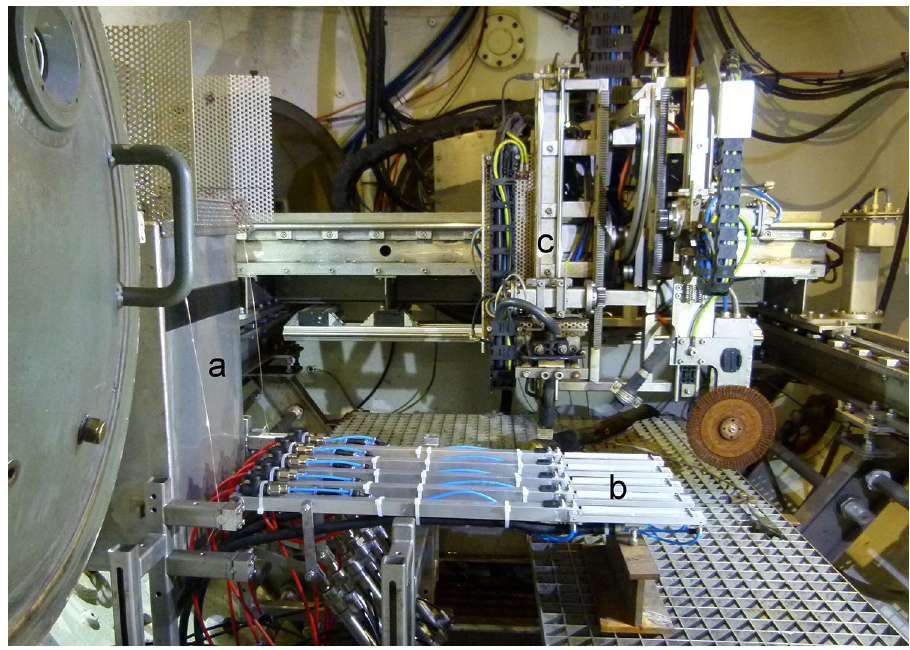
Fig. 1 Inside view of the 10 m 3 welding chamber used for wet welding. Included is a system for the weldment of hydrogen samples based on ISO 3690. a Insulated tank containing 0.2 m 3 of liquid nitrogen, b clamp- ing system for five samples according to ISO 3690—sam- ple geometry C, c welding axis with the electrode holder